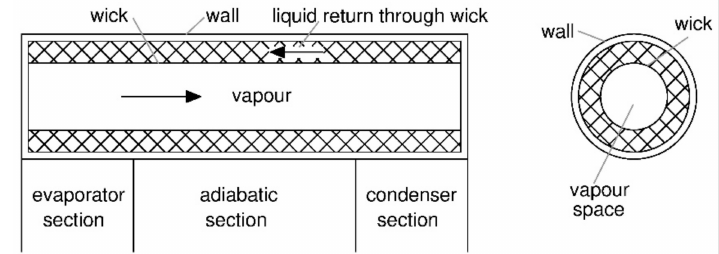
Figure 3. The main regions of heat pipe [70].